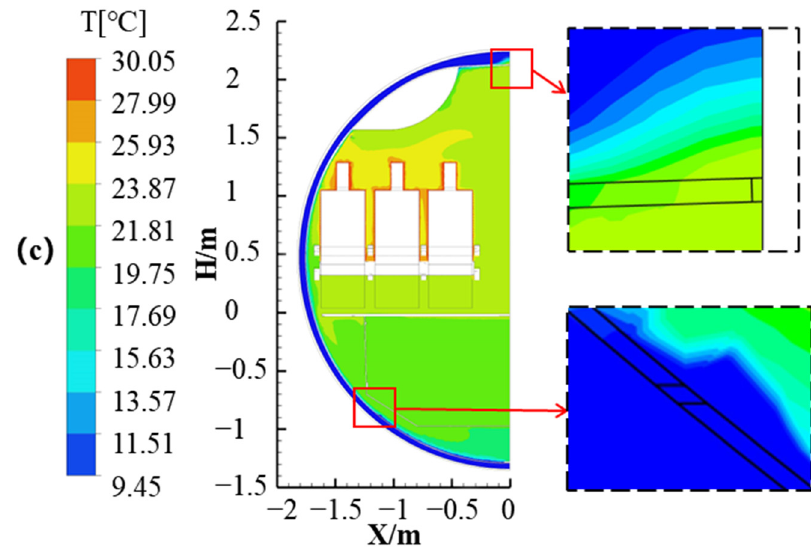
Figure 6. Distribution of air pressure, velocity, and temperature in cross-section of Case 1: ( a ) pressure, ( b ) velocity, ( c ) temperature.